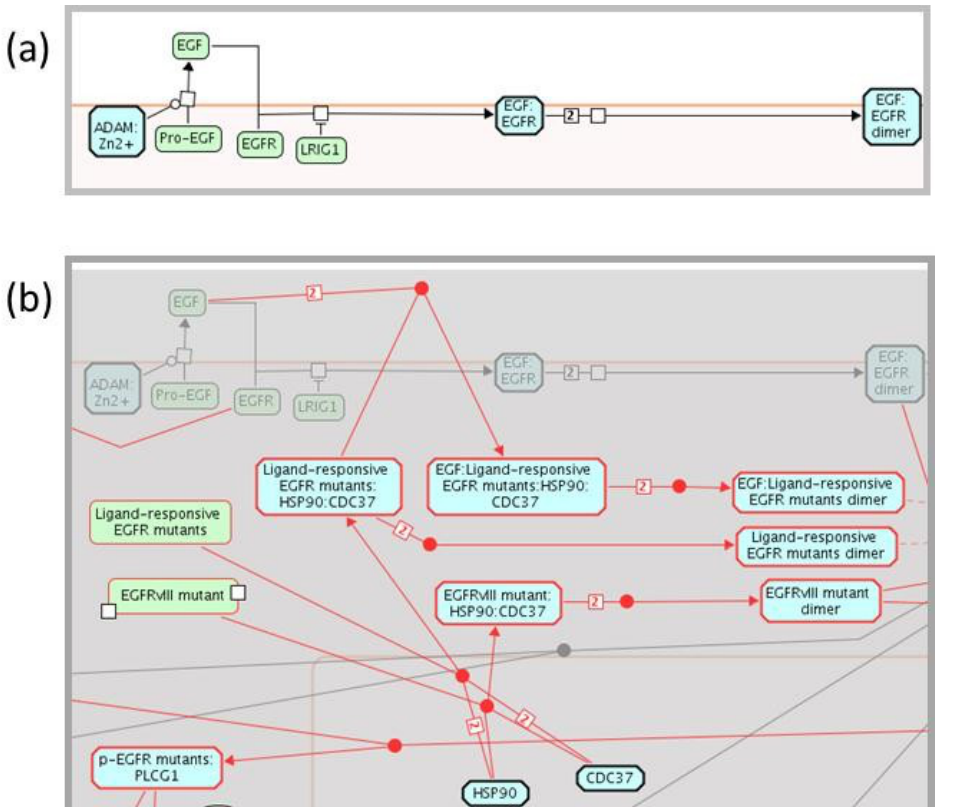
Figure 4. Display of wild-type and disease pathway diagrams. ( a ) A cancer disease attribute, assigned to events involved in cancer, instructs the browser to hide disease events when a user selects to view a wild-type pathway. ( b ) When a user selects to view a disease pathway, disease events appear in the wild type diagram, while all normal events are shaded. All disease events and physical entities with disease tags are outlined in red for easier